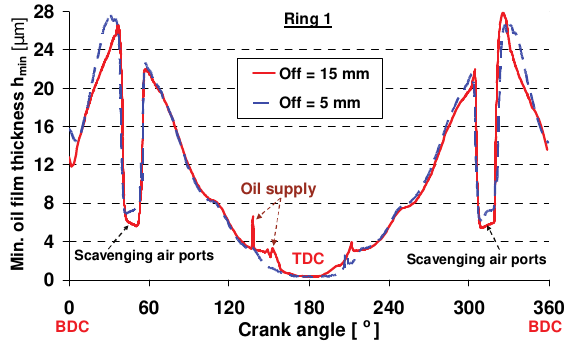
Fig. 11. Comparison of the oil film thickness h oil [ m m] left by the piston ring pack along cylinder wall in case of asymmetric profiles of all rings and symmetric profiles of rings 2, 3,